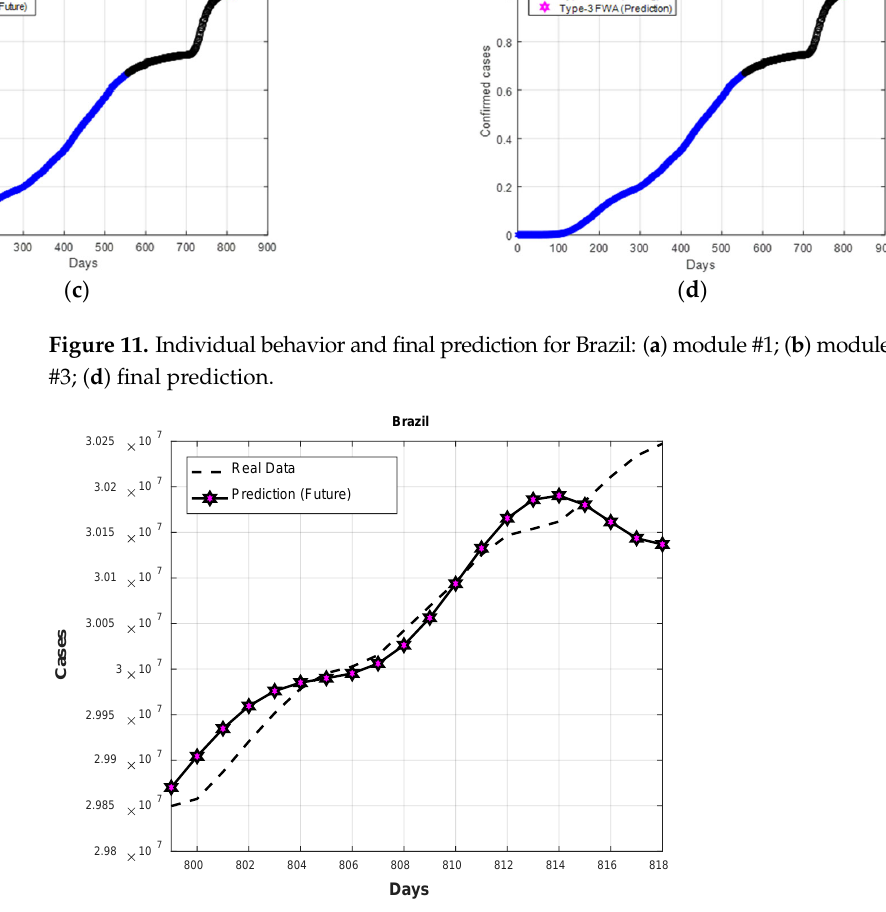
( c ) Figure 13. Type-3 fuzzy input variables (Brazil): ( a ) fuzzy input #1; ( b ) fuzzy input #2; ( c ) fuzzy input #3. In Figure 14, the average convergence obtained by both integration techniques of the 30 runs for Brazil is shown.